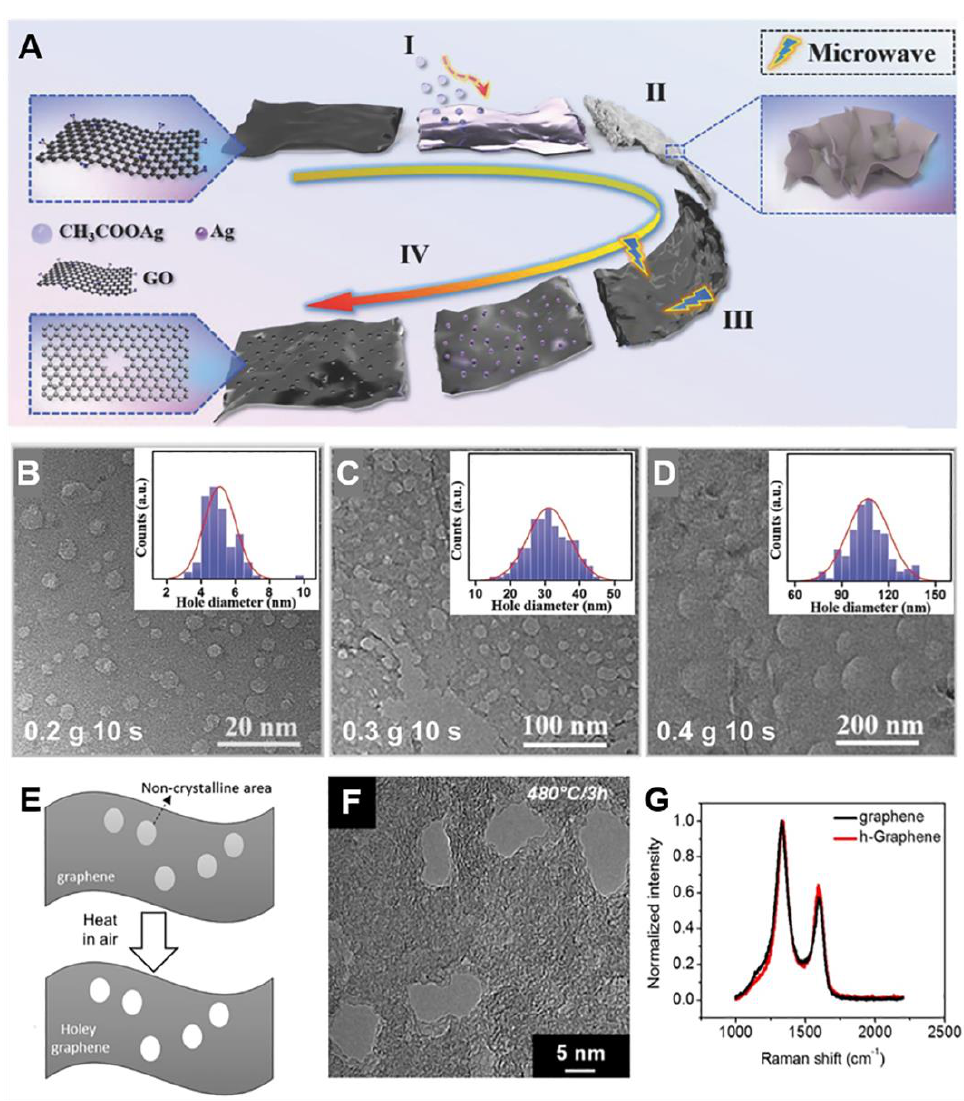
Figure 7. ( A ) Schematic of the fabrication for porous graphene. ( B – D ) HRTEM images of various porous graphene prepared by different concentrations of Ag acetate after microwave treatment for 10 s and corresponding pore diameter distribution (inset). ( A – D ) Reprinted with permission